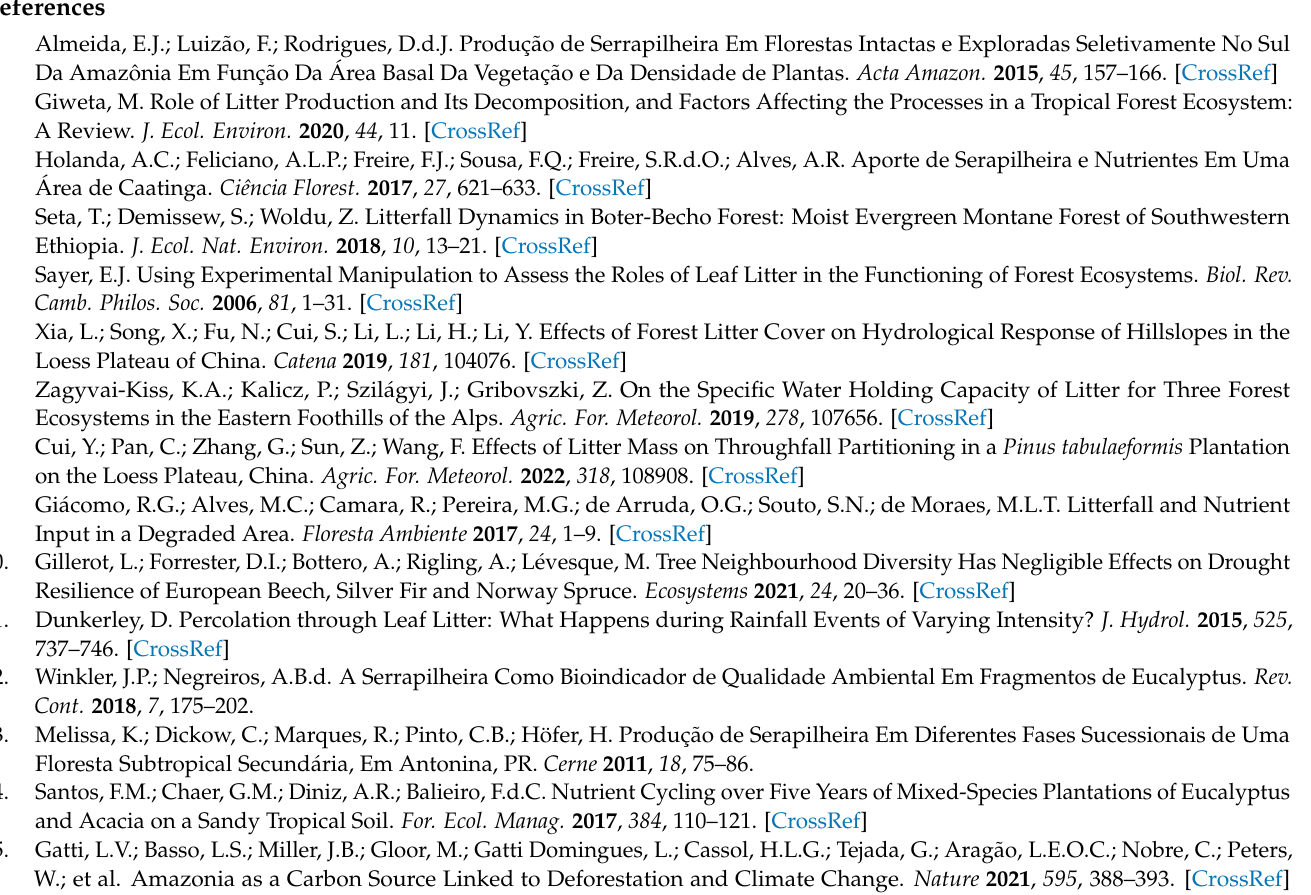
Brazil. Table S4: Litter fractions descriptive analyses for unlogged (UL) and logged (L) at Jamari National Forest, Rond ô nia, Brazil. Table S5: Effective litter water-holding capacity [EWC, %],